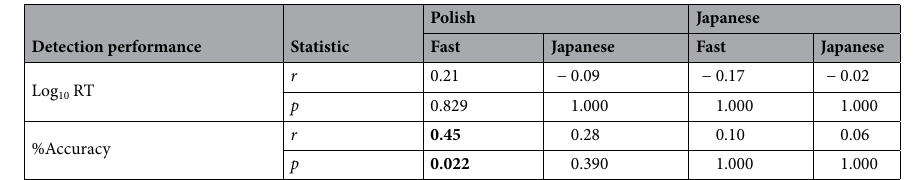
Table 2. Correlation coefficients between preference ratings and detection performance (log 10 reaction time [RT] and percent accuracy) for fast food and Japanese food in Polish and Japanese participants. P -values were Bonferroni-corrected for each detection performance measure. Significant results are shown in